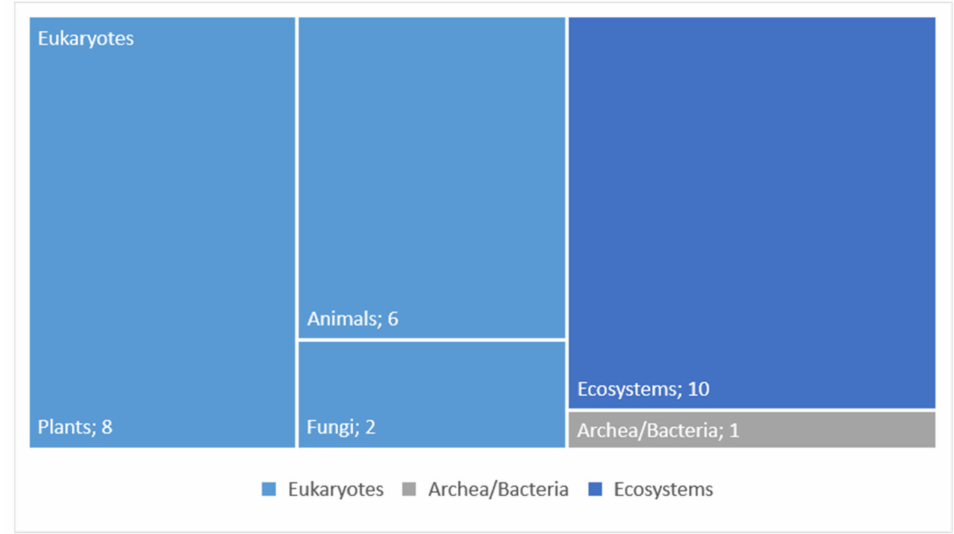
Figure 11. Occurrence of the different types of biological models ( n = number of observations).